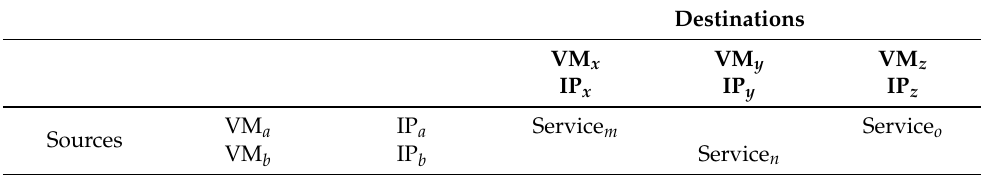
Table 1. Reachability